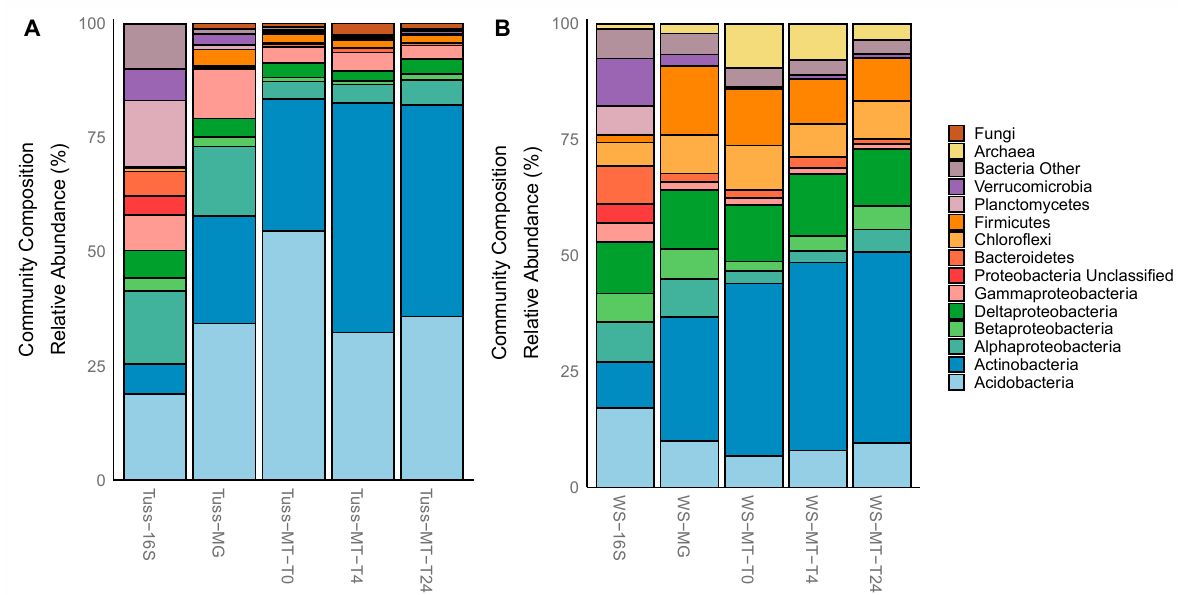
Figure 1. Microbial community composition within ( A ) tussock tundra and ( B ) wet sedge tundra soils based on the mean relative abundance of 16S rRNA amplicons, GPM-normalized metagenome (MG), and TPM-normalized metatranscriptome (MT) genes belonging to Ribosome KEGG tier III pathway. Table 3. Relative abundance calculated for tussock tundra and wet sedge tundra communities averaged across all sam- pling time points based on KEGG tier III “Ribosome” category from the GPM-normalized metagenome (MG) and TPM- normalized metatranscriptome (MT) datasets (mean ± SD). Asterisks indicate the significance of differences in mean pair- wise similarity among tundra communities (paired t -test; *** p < 0.001, ** p < 0.01, * p < 0.05; NS = no statistically significant difference).